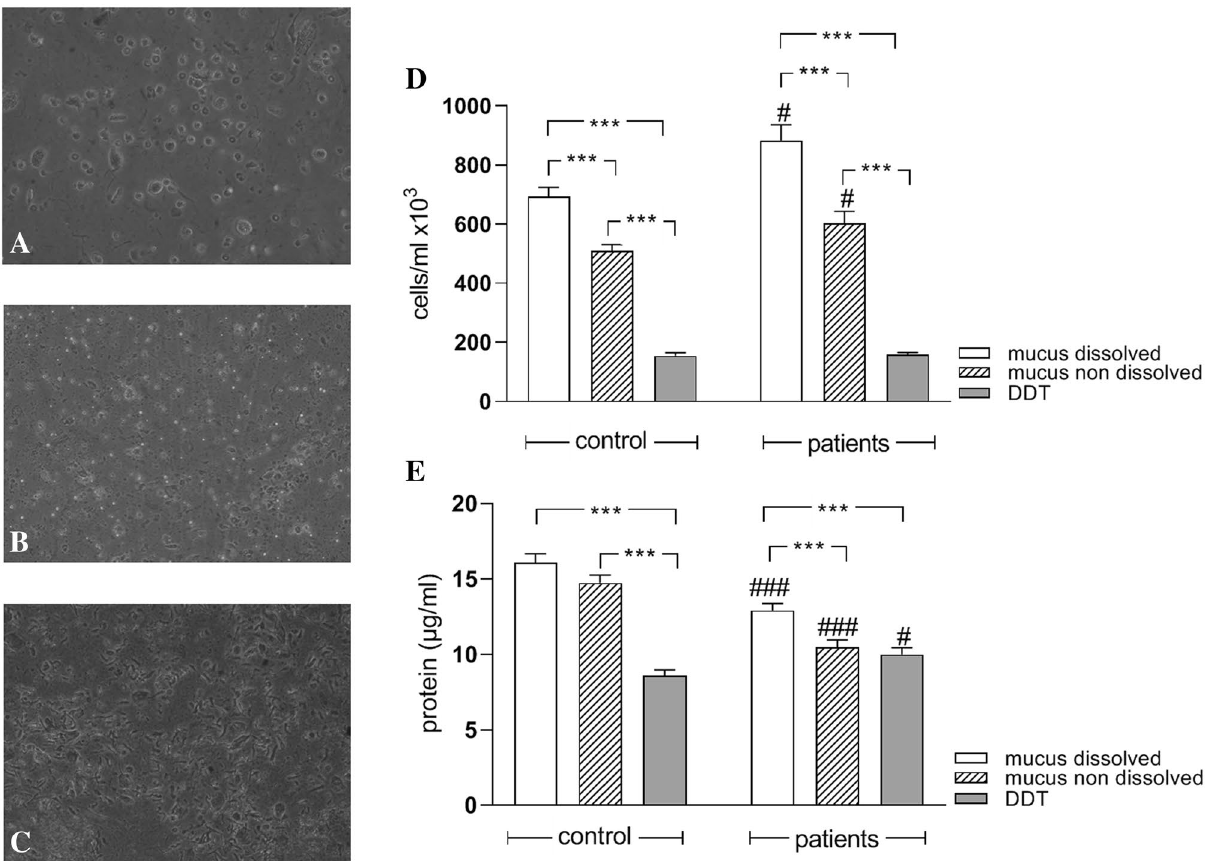
Figure 1. Images of mucus dissolved ( A ), mucus non dissolved ( B ) and dithiothreitol (DDT) dissolved ( C ) samples at 20 × magnification. Cell counts ( D ) and protein levels ( E ) in samples from control and mechanically ventilated patients, with mechanical dissolution (mucus dissolved), without mechanical dissolution (mucus non dissolved) or DDT procedure. Values are presented as mean ± SEM of 25 samples from control and 48 samples from mechanically ventilated patients. *** p < 0.001 for comparisons between groups (ANOVA Bonferonni’s post hoc test) and # p < 0.05, ### p < 0.001 compared to the relative control samples (Mann–Whitney